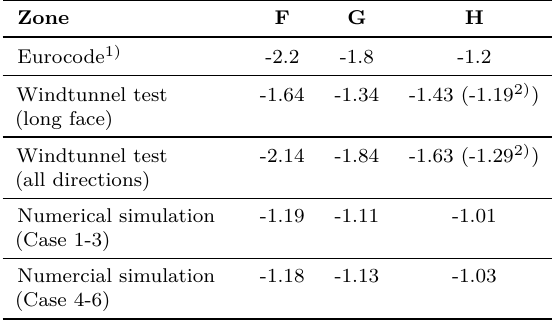
Table 2. Comparison of the external pressure coeffi- cients c pe for the roof construction. 1) c